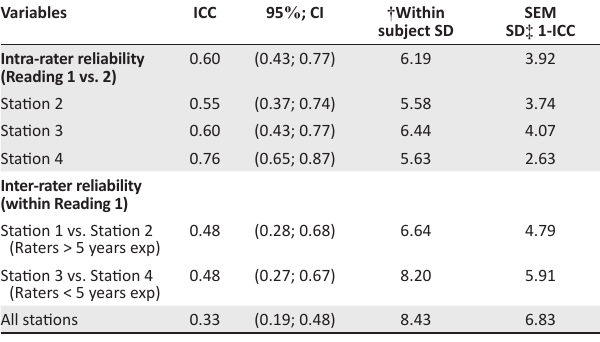
TABLE 5: Intra-class correlation coefficient describing inter- and intra-rater reliability.